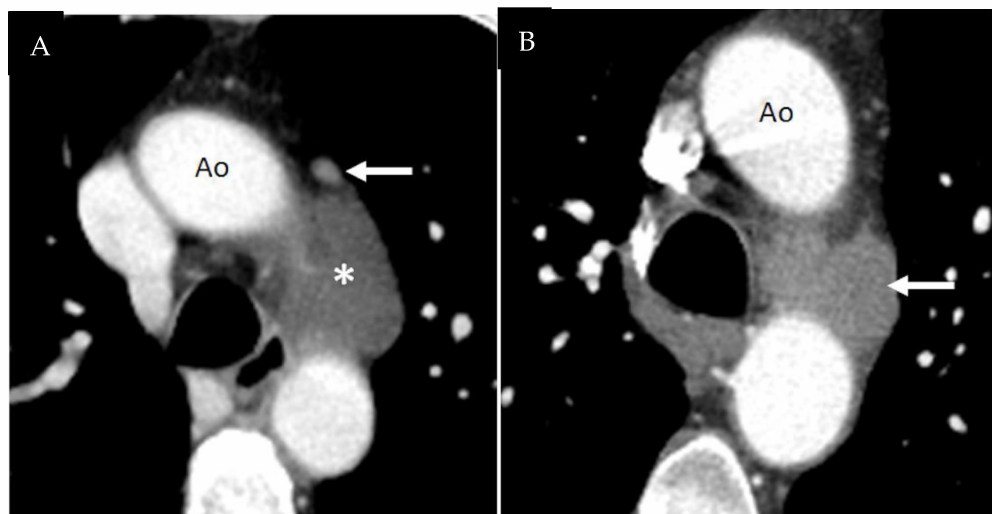
Figure 4. Fluid versus metastatic disease in the AP window recess. ( A ) A 69 year-old woman with melanoma. Contrast-enhanced axial CT shows pericardial fluid distending the AP window recess (*). Note the small lymph node (arrow) anterior to the recess. ( B ) A 64 year-old man with lung cancer. Contrast-enhanced axial CT shows adenopathy at the AP window (arrow) and low left paratracheal region. Soft-tissue attenuation and lobular contour are features that differentiate adenopathy from a fluid-filled pericardial recess. Ao = ascending aorta. Reprinted from Shroff G.S. et al. Pitfalls in oncologic imaging of the pericardium on CT and PET/CT [4].